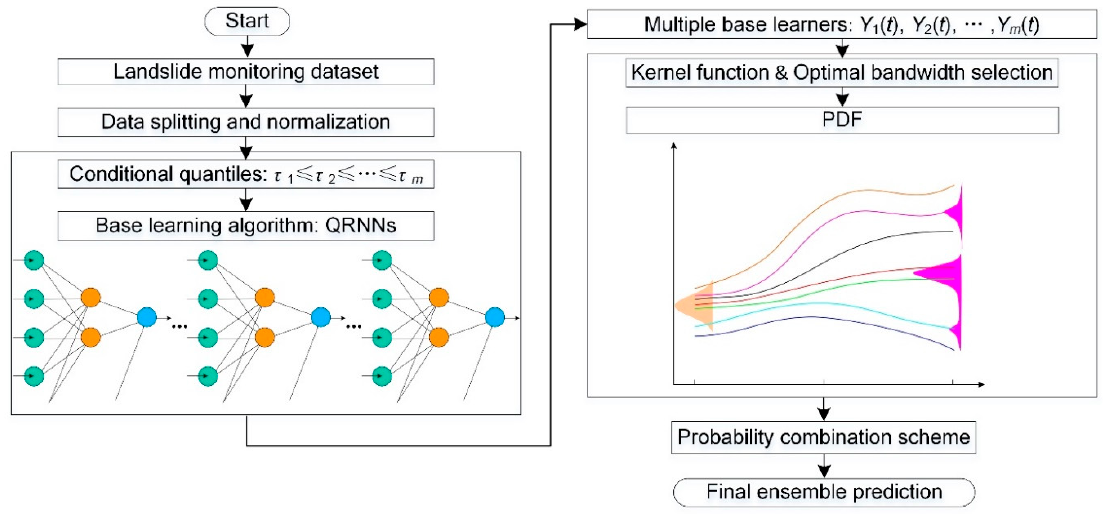
Figure 2. The overall flowchart of ensemble prediction based on the quantile regression neural networks and kernel density estimation (QRNNs-KDE)